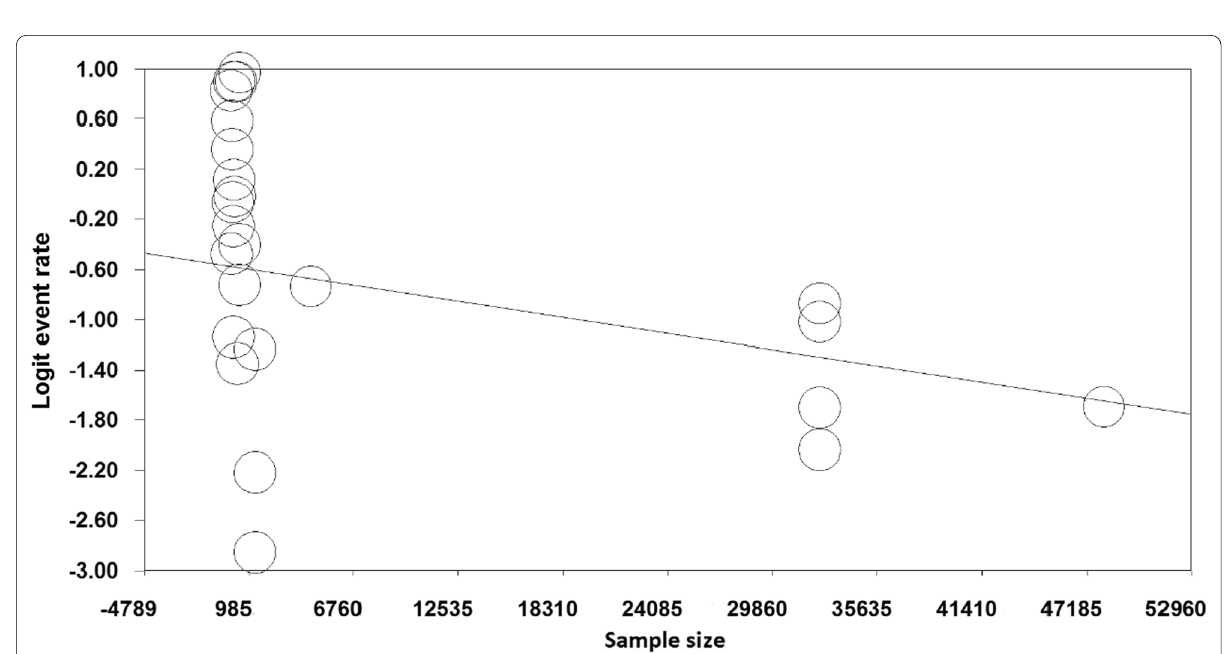
Fig. 5 Meta‑regression of the prevalence of polypharmacy in COVID‑19 patients by sample